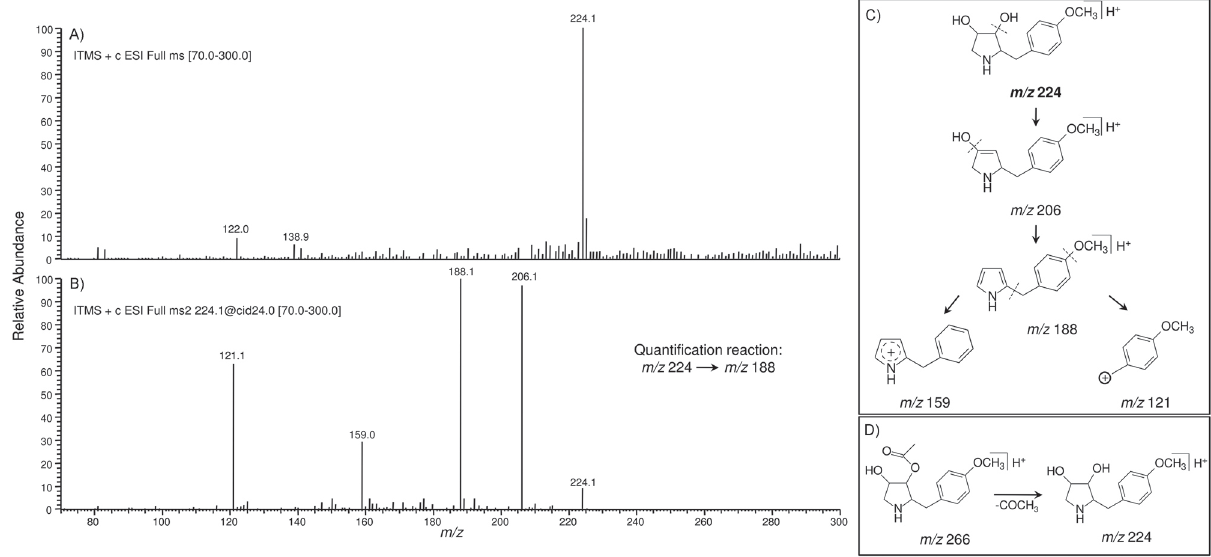
FIGURE 3 - Deacetylanisomycins’: A) mass spectrum, B) MS/MS spectrum, C) proposed fragmentation pathway, D) proposed formation by anisomycin